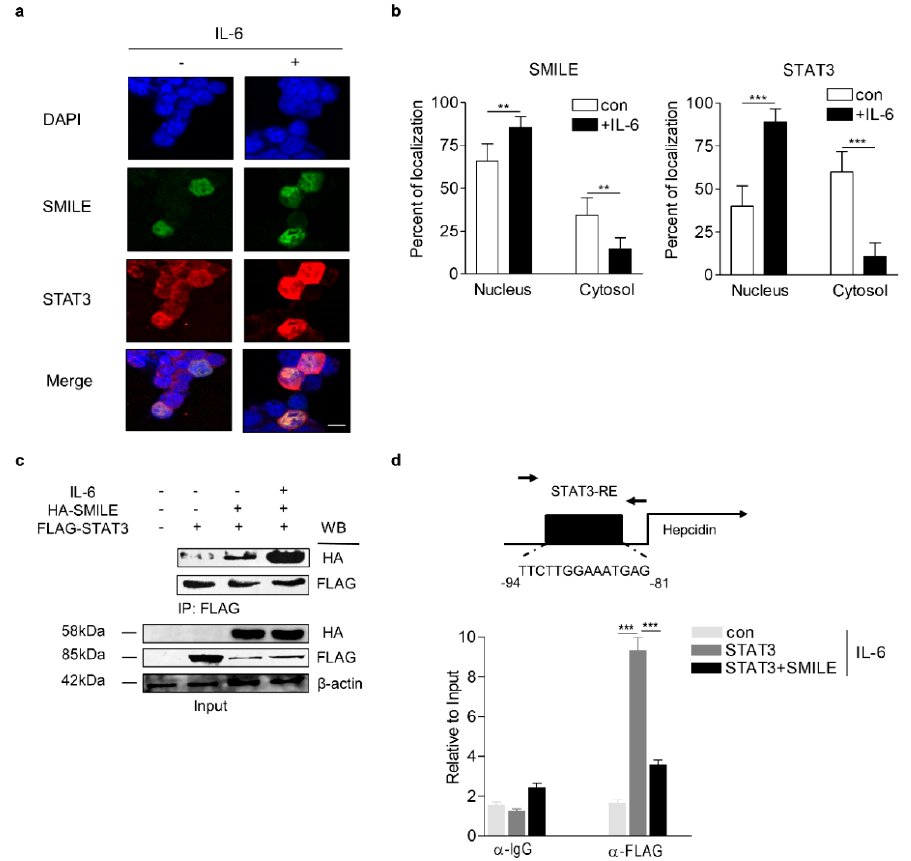
Figure 3. SMILE interacts with and represses STAT3 binding to hepcidin promoter. ( a ) Subcellular co-localization of SMILE and STAT3. HepG2 cells were co-transfected with vectors encoding GFP- SMILE and FLAG STAT3 and treated with IL-6 for 12 h. Scale bar shows 10 µ m. ( b ) Relative fluorescence of SMILE (left) and FoxO1 (right) between nucleus and cytoplasm. ( c ) Co-immunoprecipitation analysis showing interaction between SMILE and STAT3. HepG2 cells were transfected with vectors encoding HA-SMILE and FLAG-STAT3 and treated with IL-6 for 12 h. Gels for western blot analysis were run under the same experimental conditions. ( d ) ChIP assay showing inhibitory e ff ects of SMILE on STAT3 binding activity to hepcidin promoter. HepG2 cells were transfected with vectors encoding hepcidin promoter, HA-SMILE and FLAG-STAT3 and then treated with IL-6 for 12 h. Soluble chromatin was immunoprecipitated using anti-FLAG antibody. ChIP signals were measured using Q-PCR. STAT3-RE, STAT3-response element. The values are presented as means ± SD. ** P < 0.01, *** P < 0.001 using two-tailed Student’s t